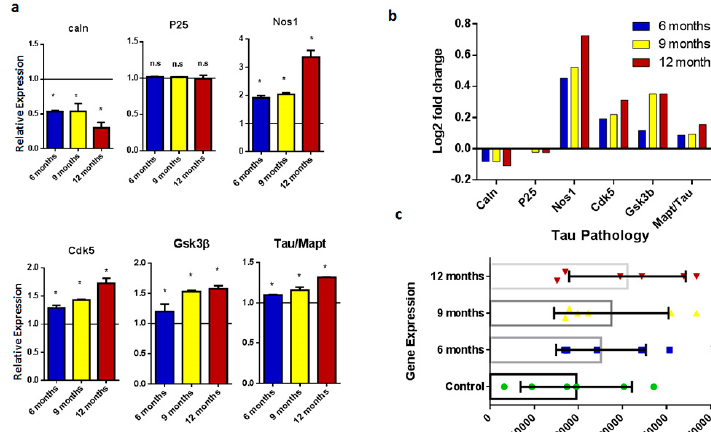
Figure 2. Expression analysis of genes involved in taupathology. ( a ) Histograms representing relative mRNA expression of Caln , Cdk5 , p25 , Nos1 , Gsk3b , and tau . Represented values are the obtained mean and SD from three individual experiments performed for each sample. The line on the x-axis at 1.0 shows the gene expression of control samples. ( b ) Bar plots representing fold-change values represented in the log2 scale showing gene expression in the brain of six-, nine-, and 12-month-old samples. Baseline shows expression in control samples. ( c ) Scattered-dot plot shows gene expression involved in tau pathology. * Expression is significantly different to WT ( p ≤ 0.05). n.s., Nonsignificant.